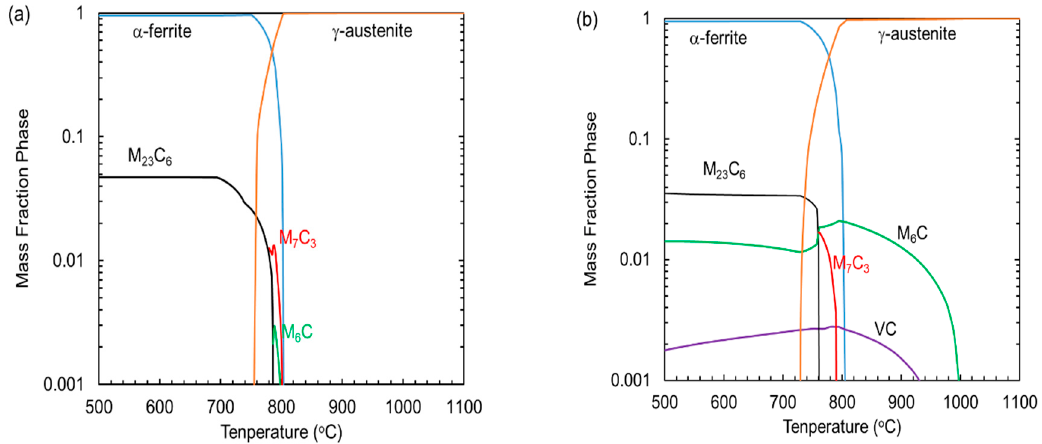
Figure 1. Equilibrium phase stability of the ( a ) bulk and ( b ) solute rich composition. Table 2. Heat treatment designation, temperature and